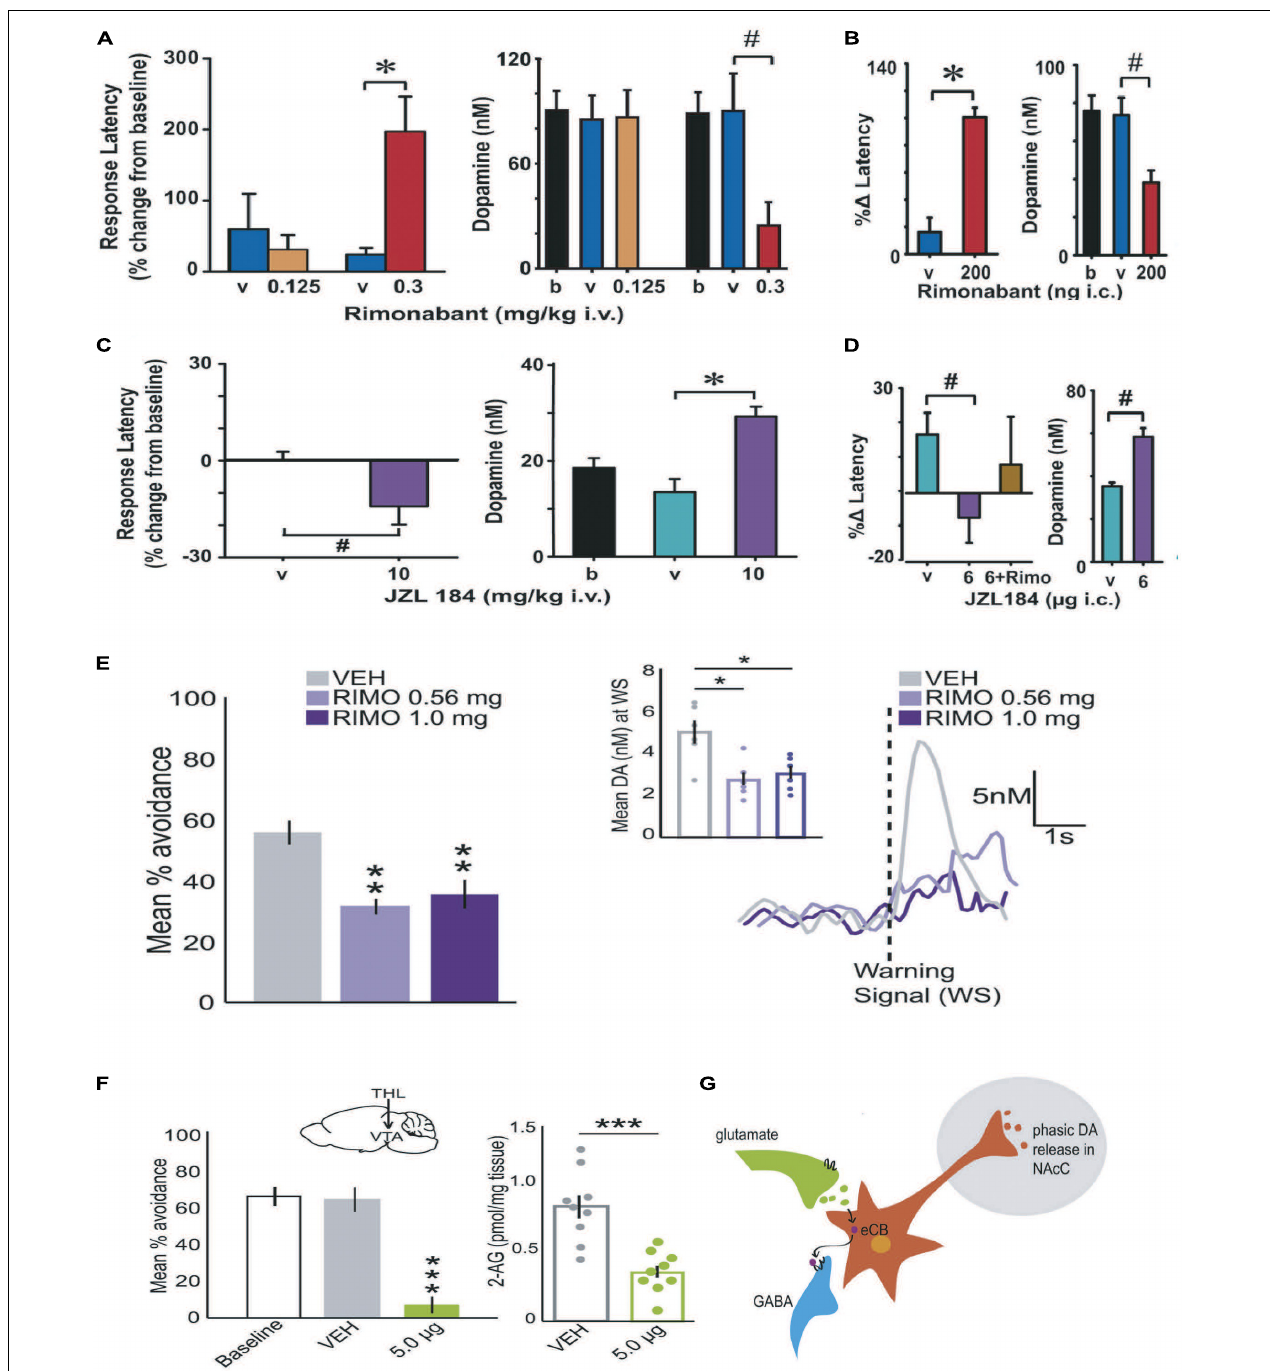
FIGURE 4 | Cannabinoids modulate DA value signals during positive and negative reinforcement maintained under an FR schedule. Positive reinforcement: Systemically treating (intravenous; IV) rats with the cannabinoid receptor antagonist rimonabant increased the latency to respond for brain stimulation reward and decreased the concentration of cue-evoked DA value signals (A). Intrategmental infusions (IC) of rimonabant recapitulated these effects on reward seeking and DA release, demonstrating that eCB modulation of DA neural activity in the VTA is alone sufficient to modulate DA release and positive reinforcement (B) . Systemically increasing 2AG levels by pre-treating rats with JZL184 (IV) reduced the latency to respond for brain stimulation reward and increased the concentration of cue-evoked DA value signals (C) . Intrategmental infusions (IC) of JZL184 recapitulated these effects, suggesting that the action of 2AG in the VTA is alone sufficient to modulate DA release and positive reinforcement (D) . Negative reinforcement: Systemic rimonabant administration (IV) reduced the number of successful avoidance responses and the concentration of DA evoked by the warning signal (E) . Inhibiting DAGL-induced synthesis of 2AG by infusing THL into the VTA decreased avoidance and reduced 2AG tissue content in the VTA (F) . Taken together, these observations generally support a DSI-model of 2AG-modulation of DA value signals (G) during positive and negative reinforcement maintained under an FR schedule. Republished from Oleson et al. (2012) and Wenzel et al. (2018). # < 0.05; ** p < 0.001; *** p ≤ 0.001.